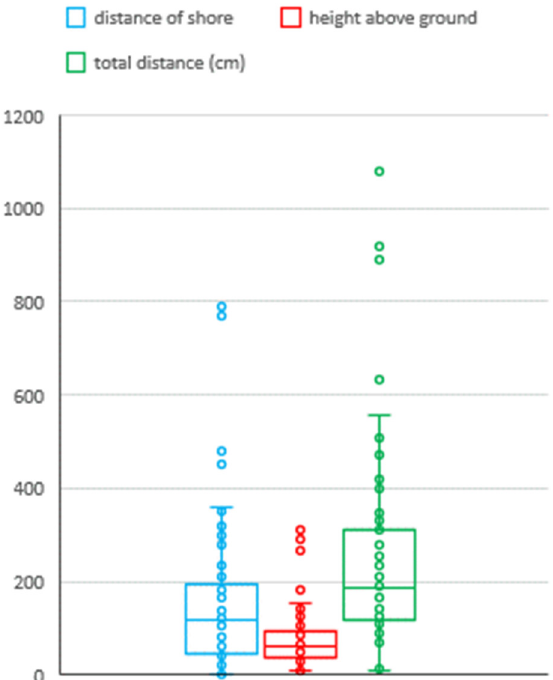
Figure 8. Variability of position of exuviae of Cordulegaster heros (distance from shore, height above ground, and total distance; all reported in cm).